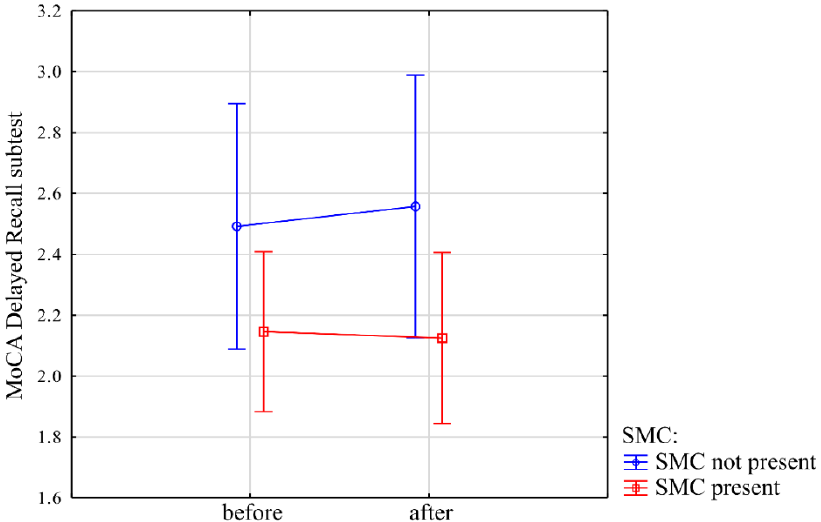
Figure 2. Interaction between time and subjective memory complaint (SMC) presence and results of MoCA Delayed Recall subtest. Y-axis (MoCA Delayed Recall subtest) represents the number of words recalled correctly in short-term verbal memory test in MoCA without the help of staff conducting the examination. X-axis (“before” and “after”) denotes the initial time-point and after two years, respectively. Blue line indicates subgroup without subjective memory complaints, while red line indicates scores of participants with subjective memory complaint.